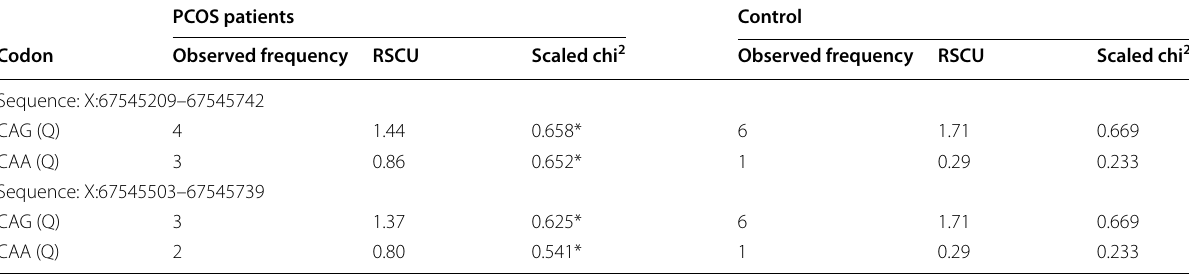
The table was generated using DNASp6 with effective number of codons (ENC): 52.961, and codon bias index (CBI): 0.510 RSCU relative synonymous codon usage. p =